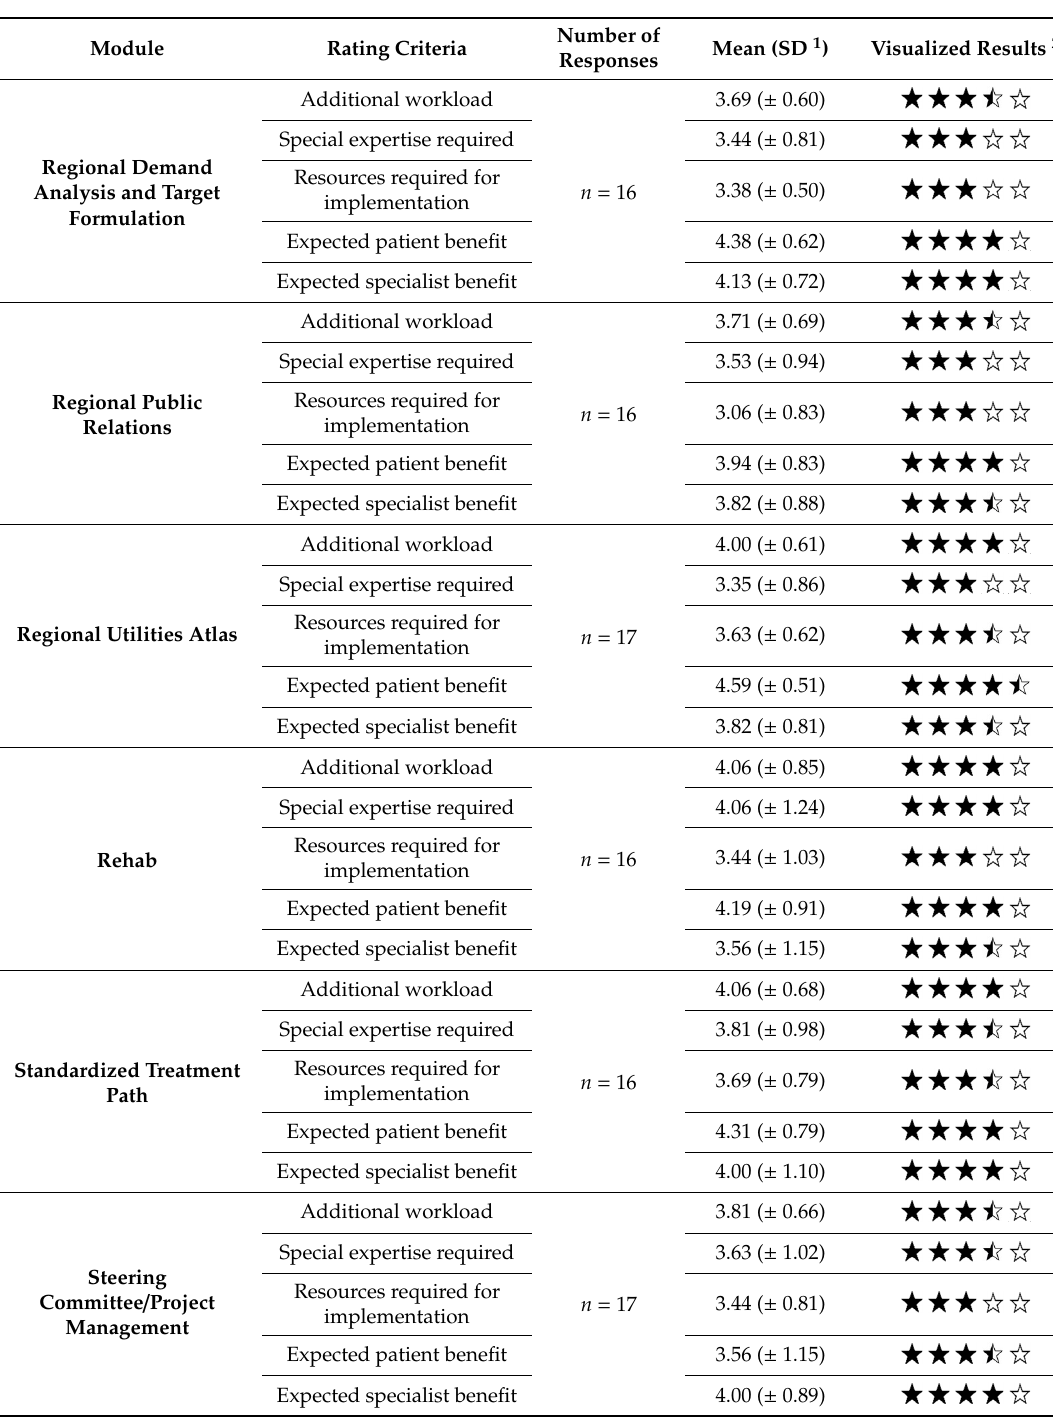
Figure 3. Box Plots for the Rating Categories and Rating Values (Modules: n = 25, Raters: n = 17) .